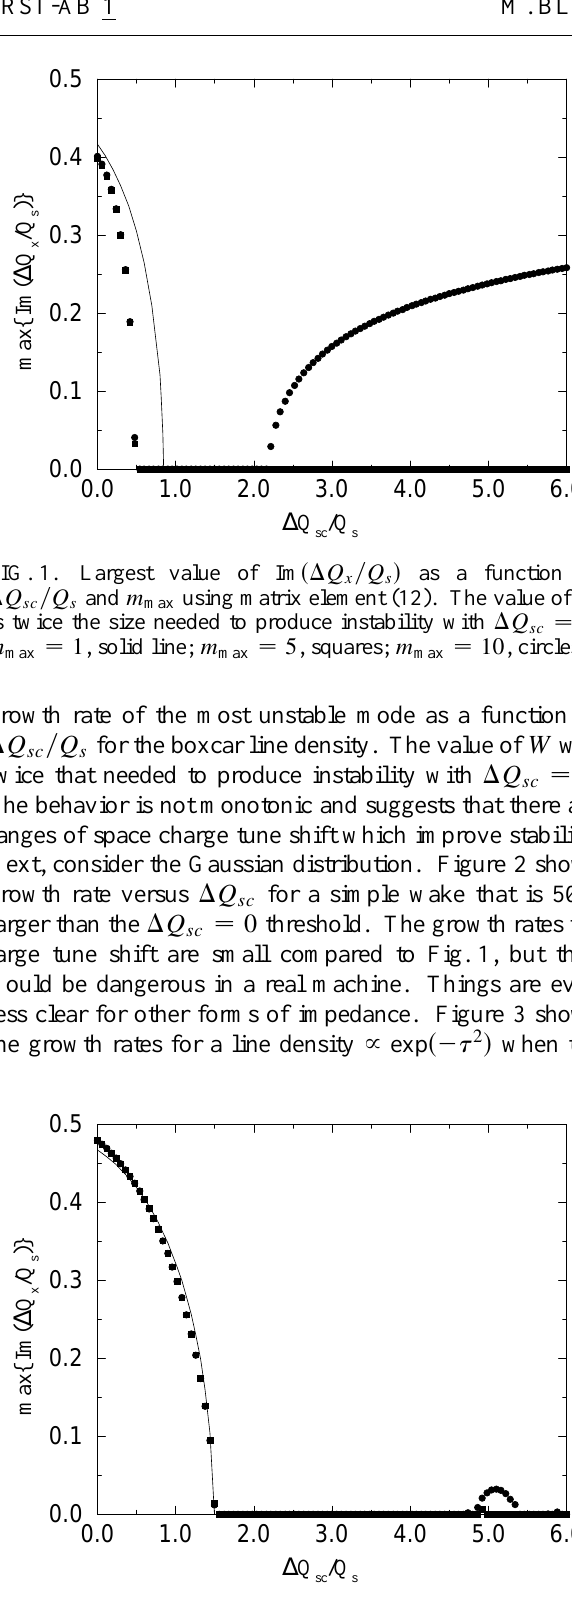
FIG. 3. Largest value of Im (cid:115) D (cid:81) (cid:120) (cid:121) (cid:81) (cid:115) (cid:100) as a function of D (cid:81) (cid:115)(cid:99) (cid:121) (cid:81) (cid:115) and (cid:109) max for the resonator impedance described in the text: (cid:109) max (cid:173) (cid:49) , solid line; (cid:109) max (cid:173) (cid:53) , squares; (cid:109) max (cid:173) (cid:49)(cid:48) , circles; (cid:109) (cid:109)(cid:97)(cid:120) (cid:173) (cid:49)(cid:53) ,